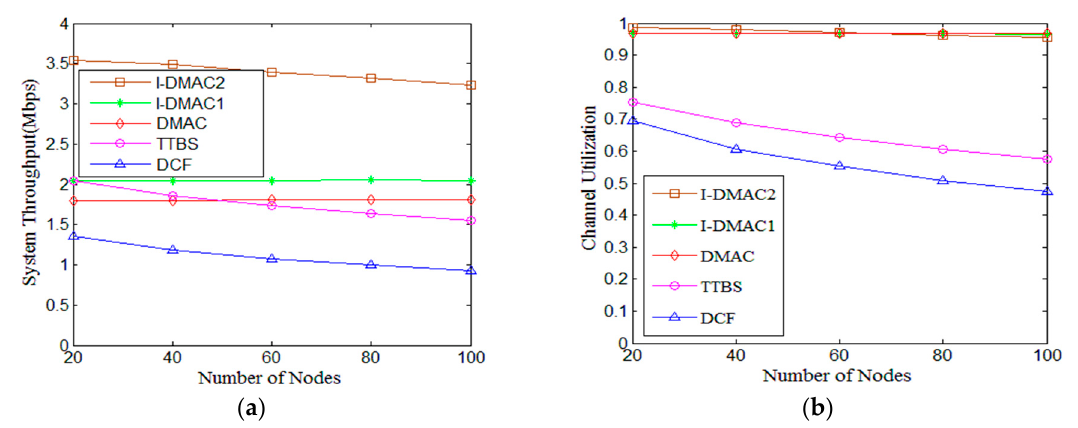
Figure6. Throughpututilizationinmulti-ratescenario. ( a )Systemthroughput; and,( b )Channelutilization. Figure 6. Throughput and utilization in multi-rate scenario. ( a ) System throughput; and, ( b ) Channel utilization.